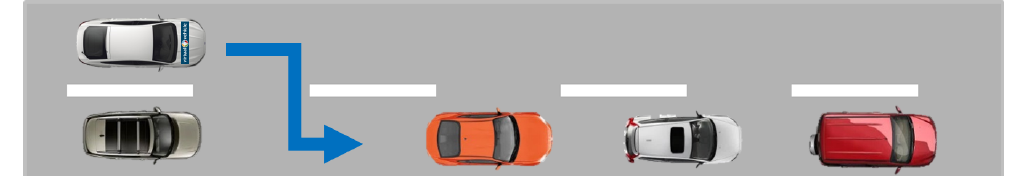
Figure 9. M86 Test Scenario 1 with the ego-vehicle cutting